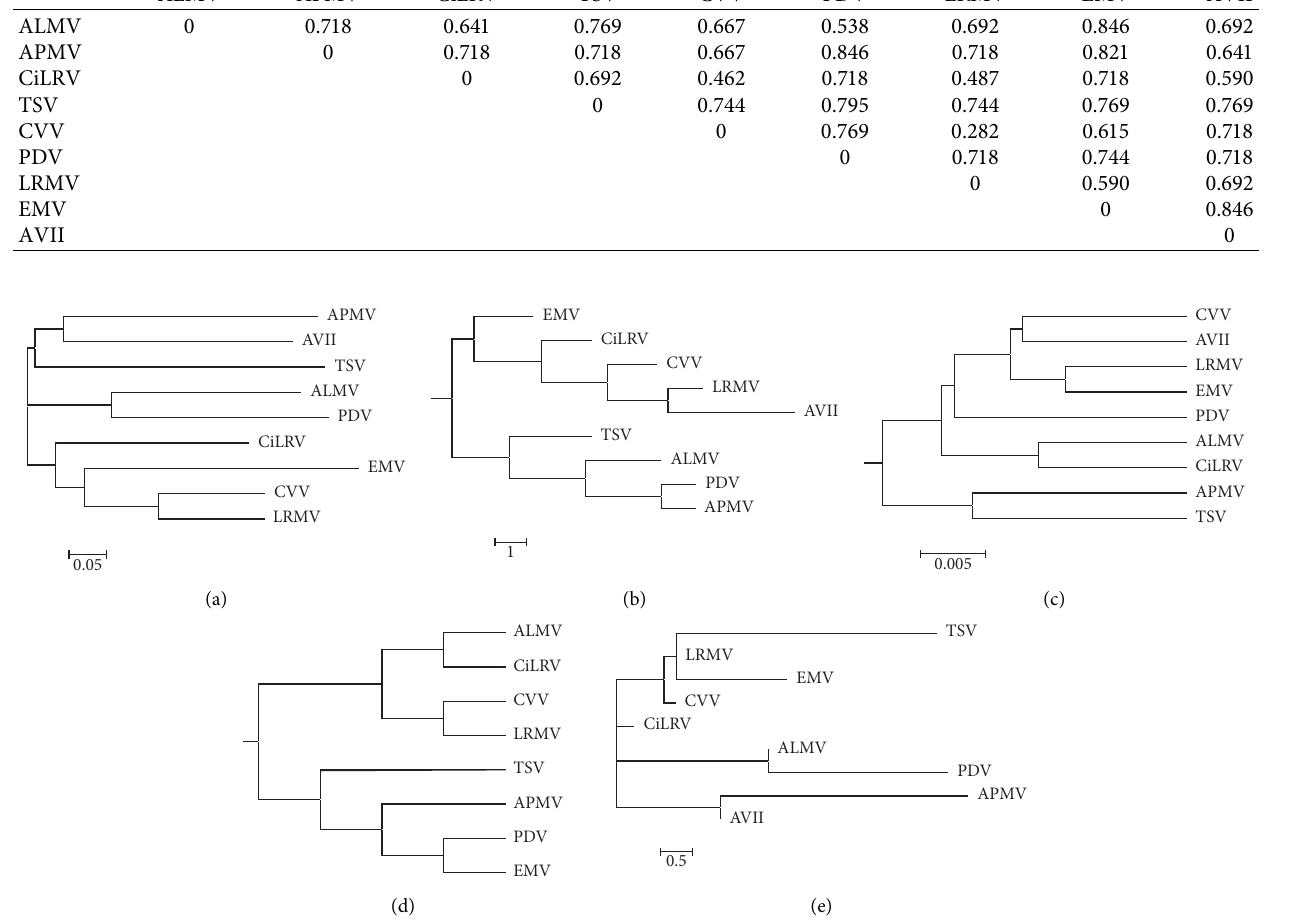
Figure 6: The cluster analysis graph of nine virus sequences generated by (a) our method, (b) Li’s method, (c) RNApdist, (d) ASPRAlign, and (e) MEGA software. Table 2: 11 noncoding RNA sequences from the RFAM and NONCODEv5